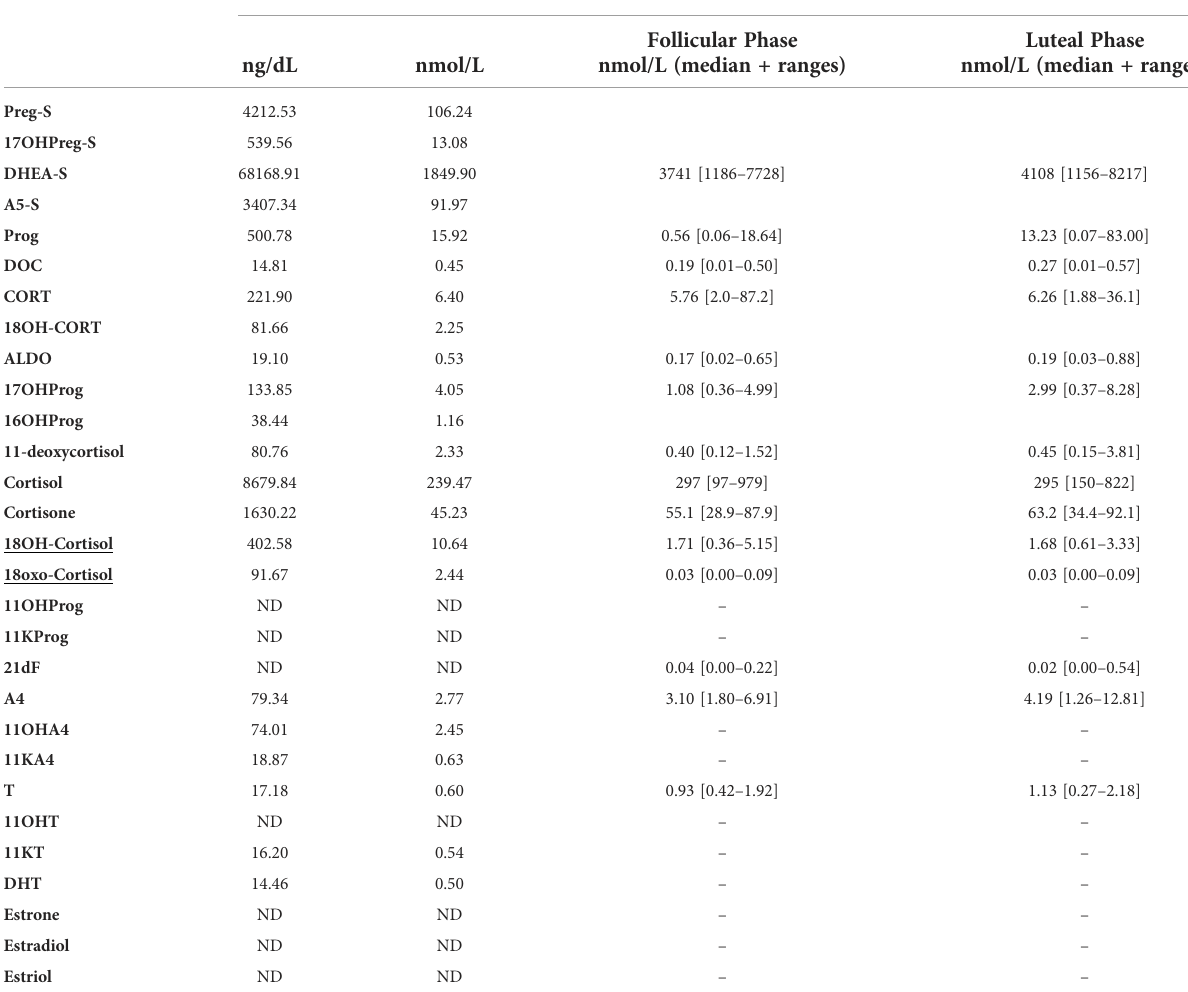
TABLE 1 LC-MS/MS quanti fi cation of 29 steroids in